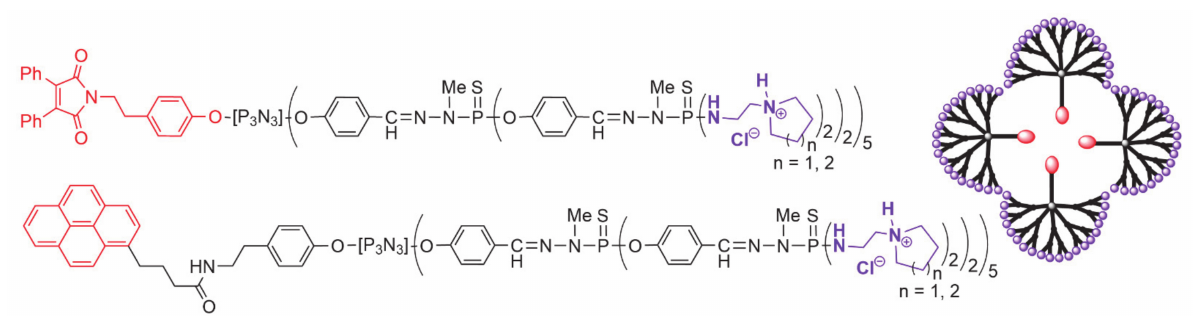
Figure 6. Amphiphilic dendrons functionalized with either maleimide or pyrene at the core and 20 cyclic ammoniums on the surface (2-(pyrrolidin-1-yl)ethan-1-amine (five-membered ring) or 2-(piperidin-1-yl)ethan-1-amine (six-membered ring). Schematized association of these dendrons in micelle.